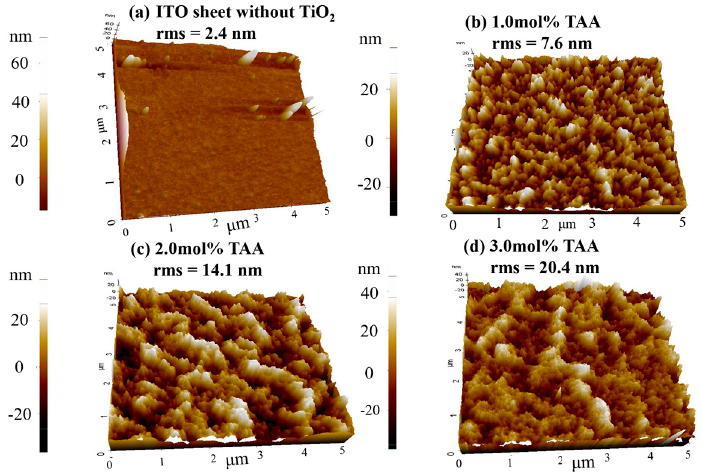
Figure 6. AFM images of the surface of the TiO 2 layers sprayed by the TiO 2 ethanol solution with the addition of TAA, ( a ) ITO sheet without TiO 2 film; ( b ) 1.0 mol % TAA; ( c ) 2.0 mol % TAA; and ( d ) 3.0 mol % TAA with respect to the TiO 2 content.